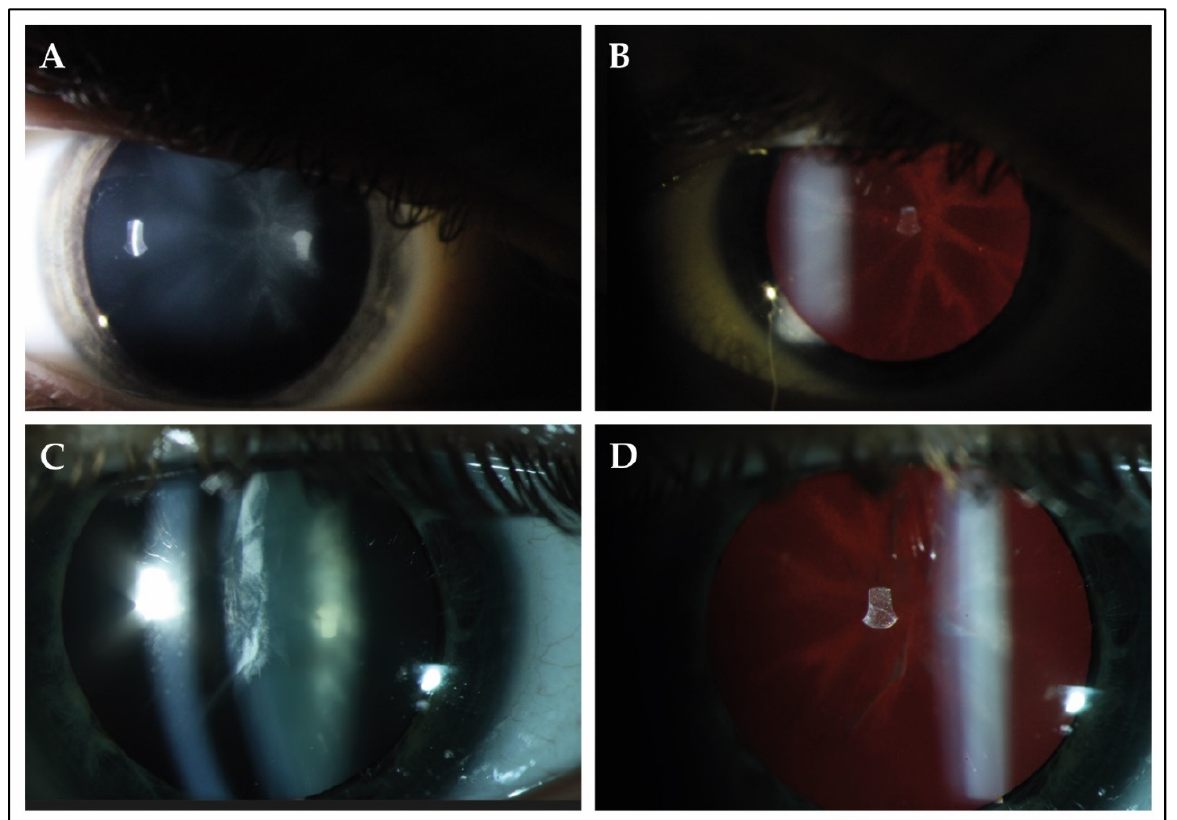
Figure 1. Slit-lamp findings in 2 patients with PHARC syndrome. ( A , B ) Slit-lamp photographs of the right eye of patient J-13 at the age of 17. Best-corrected visual acuity was 20/50 Snellen in this eye. Direct illumination demonstrated the presence of cataract in the posterior surface of the lens. Retroillumination revealed that the observed opacity followed a star-shaped distribution, which seemed to delineate the crystalline lens sutures of the posterior cortex. ( C , D) The right eye of patient L-15 (age 37) showed opacities in both the anterior and posterior cortex. Best-corrected visual acuity was 20/100 during this visit. Retroillumination showed anterior cortical cataract and a star-shaped opacity in the posterior surface.